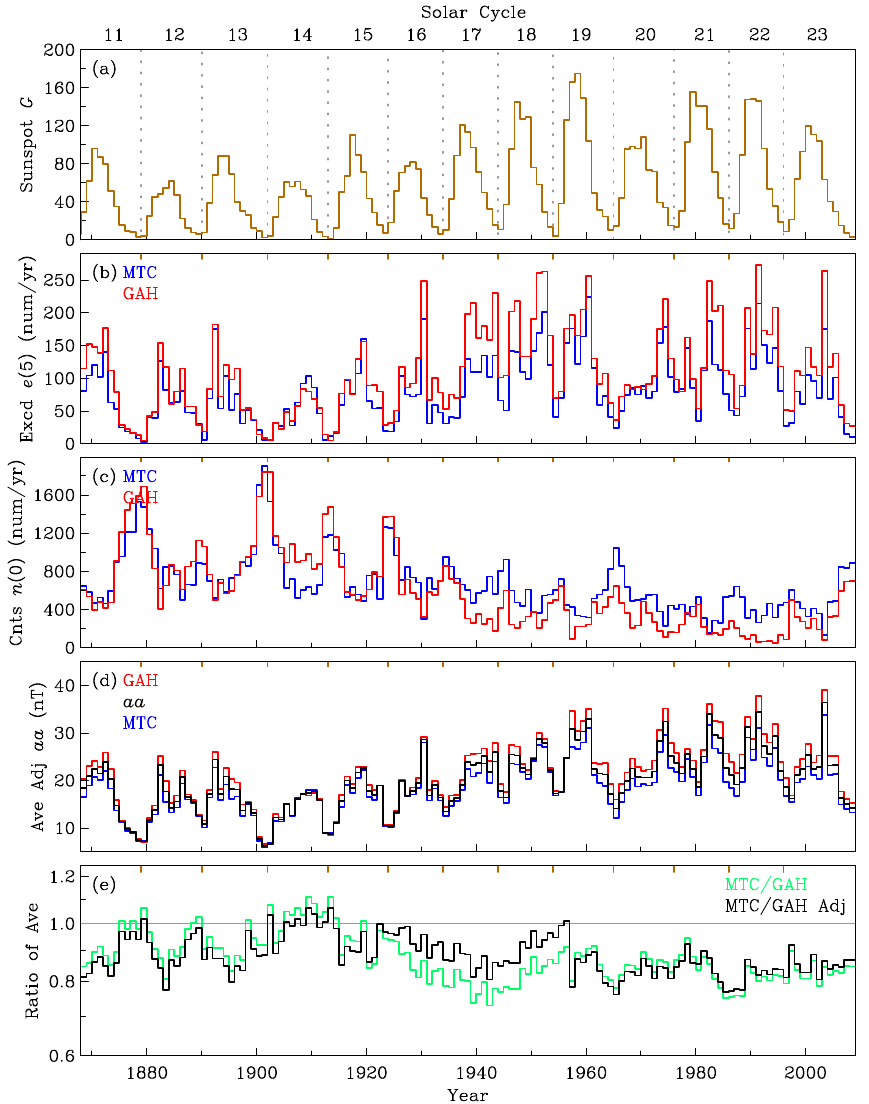
Fig. 2. Time series for 1868.0–2009.0 and solar cycles 11–23 of (a) annual means of sunspot group number G(t) , (b) annual exceedance count rates e (5 ,t ) for British GAH (red) and Australian MTC (blue) observatory groups, (c) annual occurrence count rates n (0 ,t ) for British GAH (red) and Australian MTC (blue) observatory groups, (d) annual average of adjusted aa GAH (red), aa MTC (blue), and the standard aa index (black), (e) ratio of annual averages of unadjusted a MTC /a GAH (green) and adjusted aa MTC /aa GAH (black).